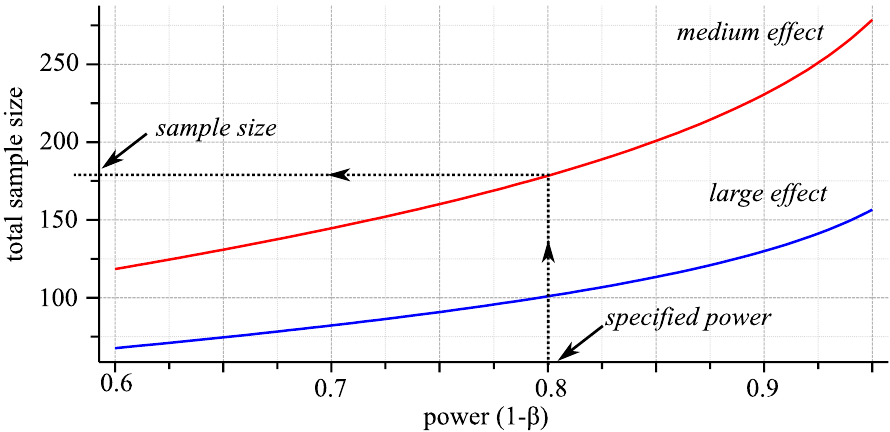
Figure 3. Calculation of sample sizes using G*Power 3.19 for a two-factor, within-subject design with four treatment groups and a single dependent